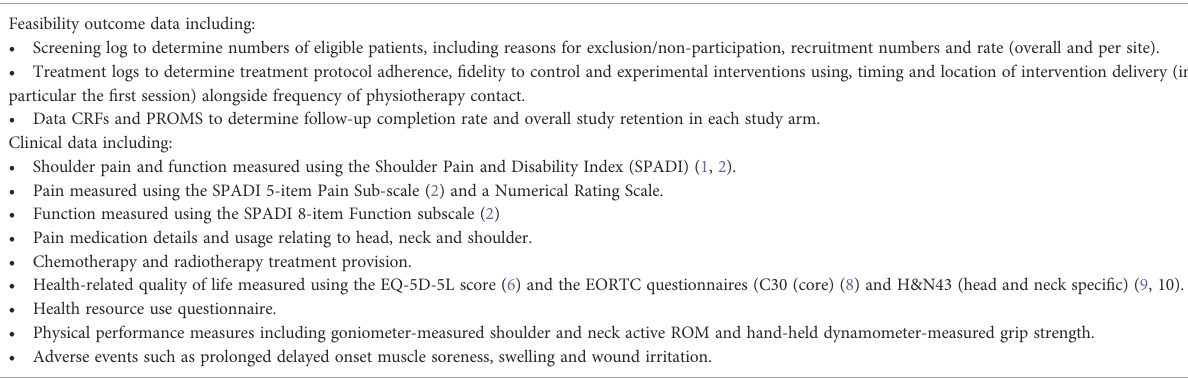
TABLE 1 Summary of data